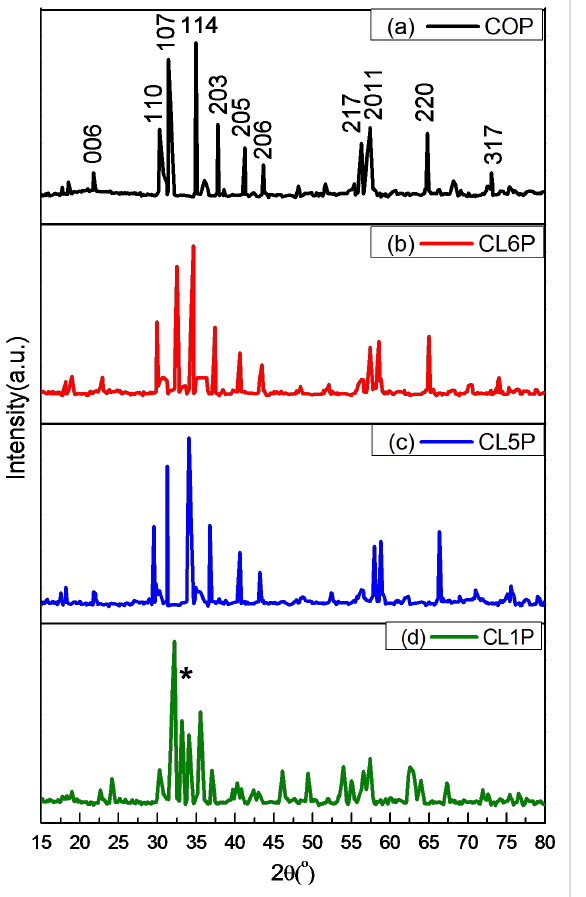
Figure 1: X-ray diffraction pattern of Ba 1 − x La x Co x Fe 12 − x O 19 /polyani- line composites: (a) x = 0.0 (COP), (b) x = 0.6 (CL6P), (c) x = 0.5 (CL5P) and (d) x = 0.1 (CL1P).